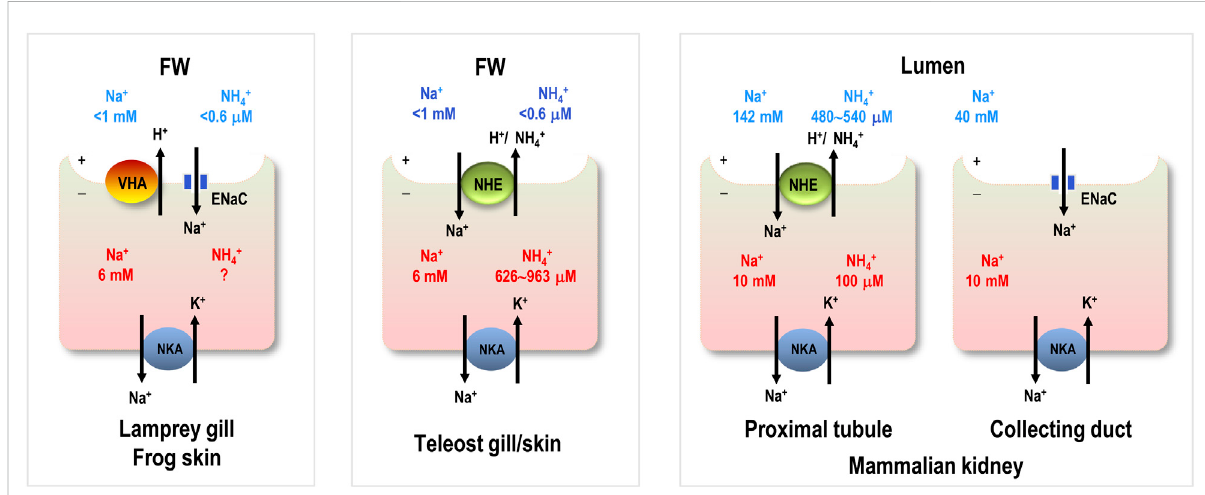
FIGURE 6 Comparison of major Na + uptake machinery among different. vertebrates. Na + and NH 4 + concentrations in freshwater (FW) habitats are from the local natural habitats. Intracellular Na + in aquatic vertebrate cells is from frog skin. Intracellular NH 4 + in teleost gill is from trout blood cells. Extracellular (lumen) and intracellular Na + and NH 4 + concentrations in humans are from the kidney and blood cells. Intracellular NH 4 + in lamprey gill and frog skin is unknown (?). ENaC, epithelial Na + channel; VHA, V type H + -ATPase; NHE, Na + /H + exchanger; NKA, Na + -K +